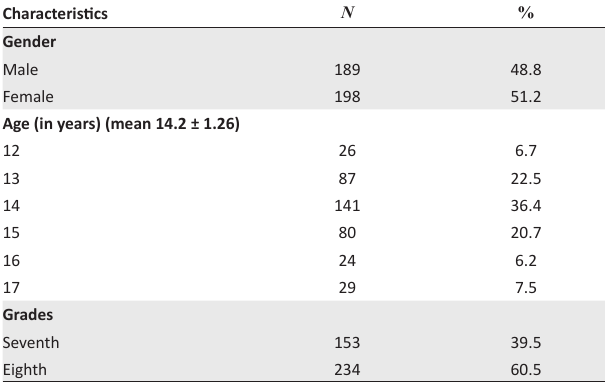
TABLE 1: Distribution of the high-school children ( N = 387) by demographic characteristics.